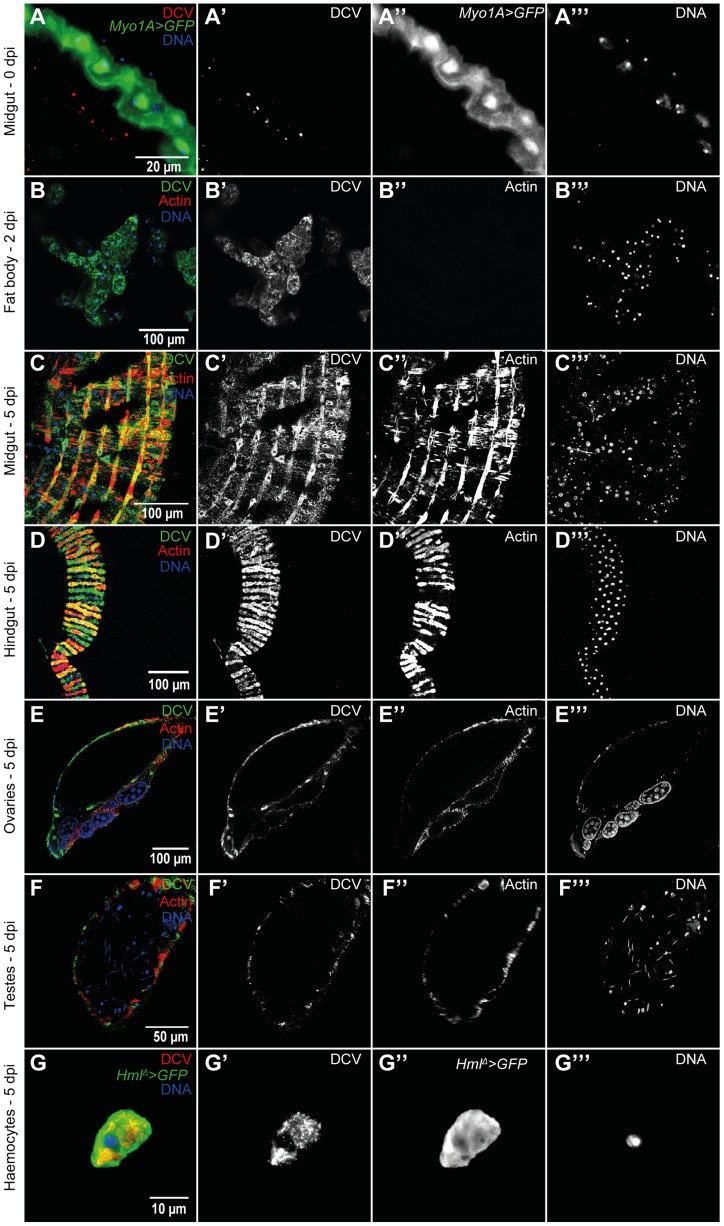
DCV tissue tropism upon oral infection.(A) DCV is present in midgut lumen at 0 dpi. Adult male guts were immunostained with antibody against DCV (red), epithelial enterocytes were marked with GFP expression (green) driven by Myo1A-Gal4 and DNA marked with TOTO3 (blue). (B) Fat body is infected with DCV 2 dpi. Midgut (C) and hindgut (D) muscle cells are infected with DCV at 5 dpi. Muscle cells of the ovarian (E) and testis (F) peritoneal sheath are also infected with DCV 5 dpi. (B–F) DCV was immunostained with an antibody (green), actin marked with phalloidin (red) and DNA marked with TOTO3 (blue). Haemocytes (G) are infected with DCV 5 dpi. Haemocytes were marked with GFP expression (green) driven by hml(delta)-Gal4, DCV was immunostained with an antibody (red), and DNA marked DAPI (blue). All tissues were dissected from adult flies. DCV infections (1011 TCID50/ml) were performed in 3–6 days old flies.